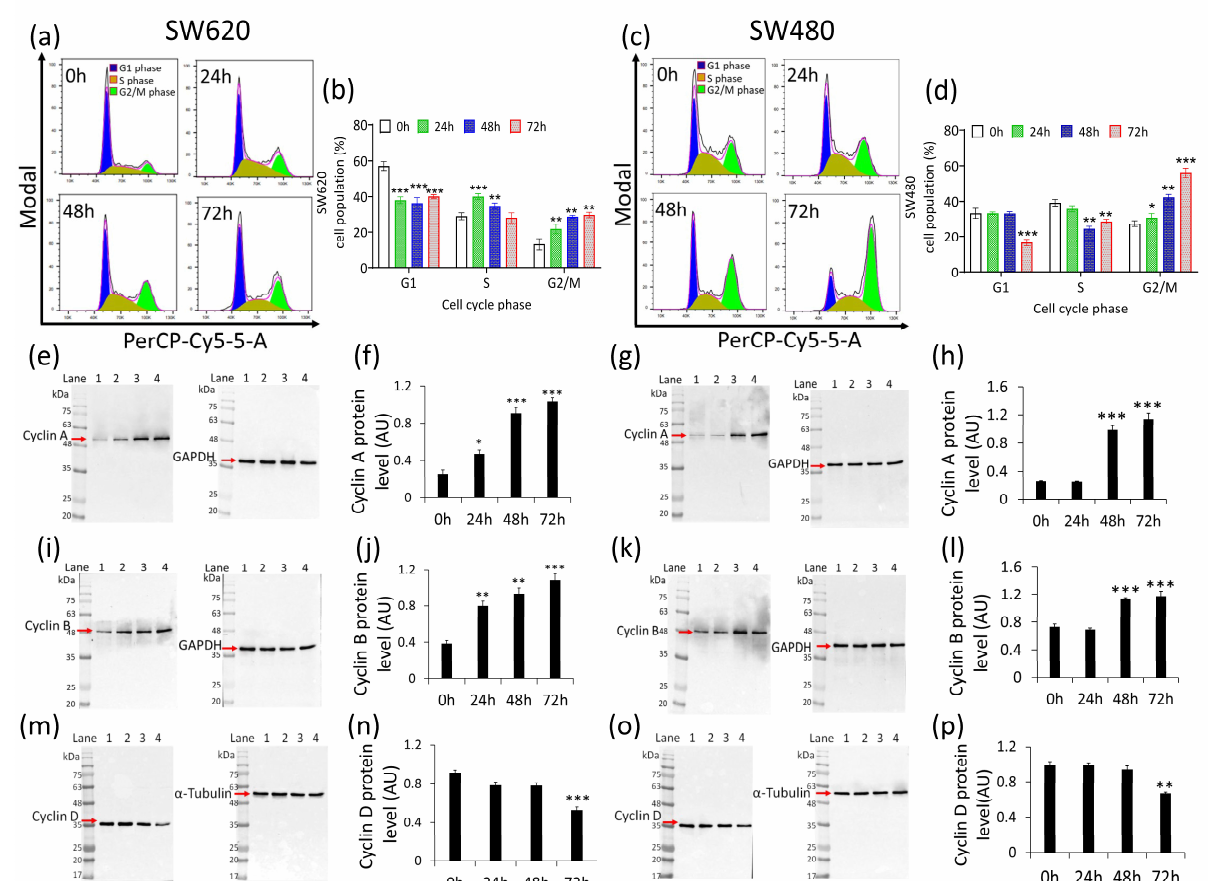
Figure 2. Effects of δVB cell cycle. Representative cell cycle analysis and average of ( a , b ) SW620 and ( c , d ) SW480 cell cycle distribution. Cells were treated with δVB (1.5 mM) for 24, 48 and 72 h. Cell cycle distribution was evaluated by flow cytometry collecting PI fluorescence as FL3-A (linear scale) and analyzed by ModFIT software (Verity Software House, Becton Dickinson, Topsham, ME, USA). For each sample, at least 10,000 events were acquired. Representative full-length blots of Western blotting analysis of cyclin A ( e – h ), cyclin B1 ( i – l ) and cyclin D ( m – p ) in SW620 and SW480 cells, respectively. Lane 1 = 0 h; lane 2= 24 h, lane 3 = 48 h, lane 4 = 72 h. Before lane 1; molecular weight markers (G266, Applied Biological Materials Inc., Richmond, BC, Canada). Protein expression was calculated, after normalization with internal control (α-tubulin or GAPDH), with ImageJ software and results expressed as arbitrary units (AU). * p < 0.05 vs. Ctr; ** p < 0.01 vs. Ctr; *** p < 0.001 vs. Ctr.